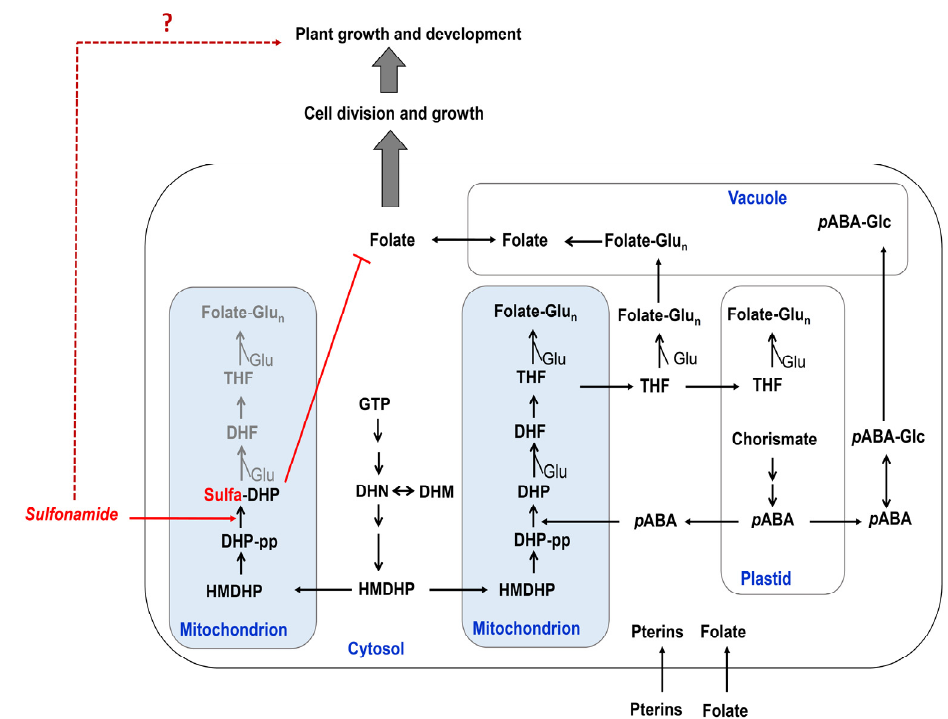
Figure 2. The folate biosynthetic pathway in a plant cell. Pterin synthesis starts with GTP conversion into HMDHP by several steps in the cytosol. p ABA synthesis occurs in plastids from a chorismate precursor. All three structural parts (pterin, p ABA, and glutamate) are assembled in the mitochondria and form THF by sequential steps. Sulfonamides can replace p ABA and convert sulfa-DHP, a newly synthesized metabolite in a plant cell system. Sulfa-DHP terminates the other subsequent steps for folate biosynthesis. GTP, guanosine triphosphate; HMDHP, 6-hydroxymethyldihydropterin; DHN, dihydroneopterin; DHM, dihydromonapterin; HMDHP DHF, dihydrofolate; DHP, dihydropteroate; DHP-pp, dihydropteroate pyrophosphate; pABA, para-aminobenzoic acid; THF, tetrahydrofolate; Glu, Glutamate; THF-Glu(n), tetrahydrofolate polyglutamate; Glc, glucose.